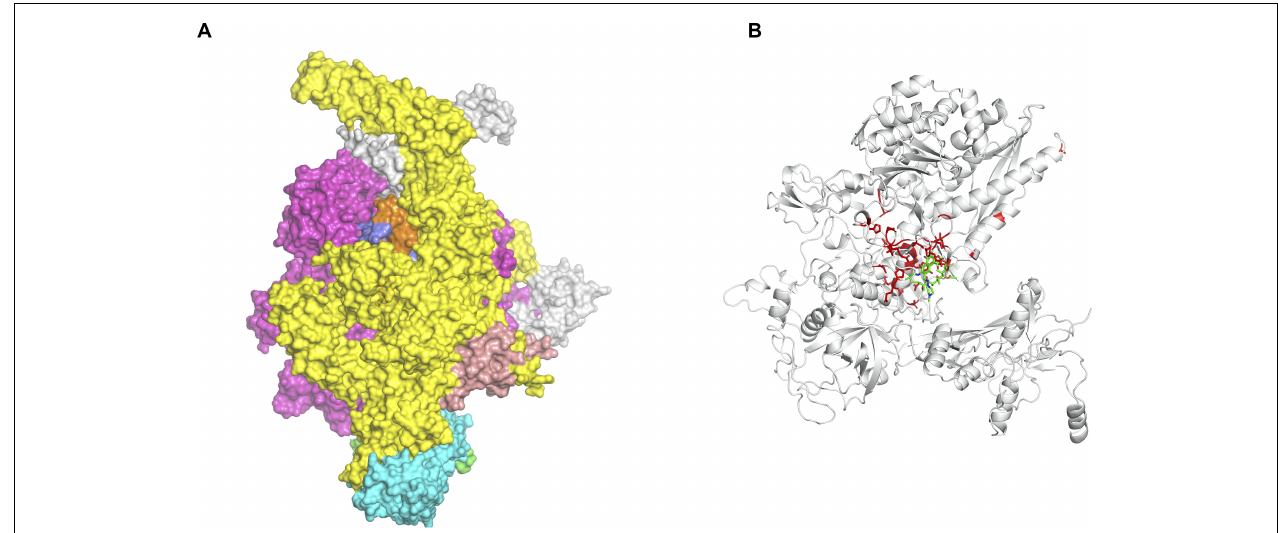
FIGURE 1 | (A) The hetero-hexameric model of the holoenzyme complex of RNA polymerase in Mycobacterium leprae . The colors represent each chain in the model ( β , β (cid:48) , α (cid:48) , α (cid:48)(cid:48) , ω , σ subunits) (Vedithi et al., 2018). (B) The ß-subunit of RNA polymerase (RpoB) with mutations (highlighted in red). Mutations at these residue positions are known to confer rifampin resistance in leprosy. Rifampin is colored in green (Vedithi et al.,